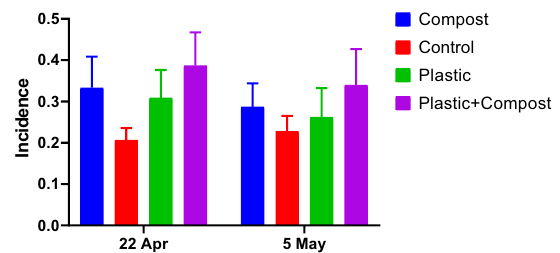
Fig. 2 Disease incidence of tomato plants across treatments